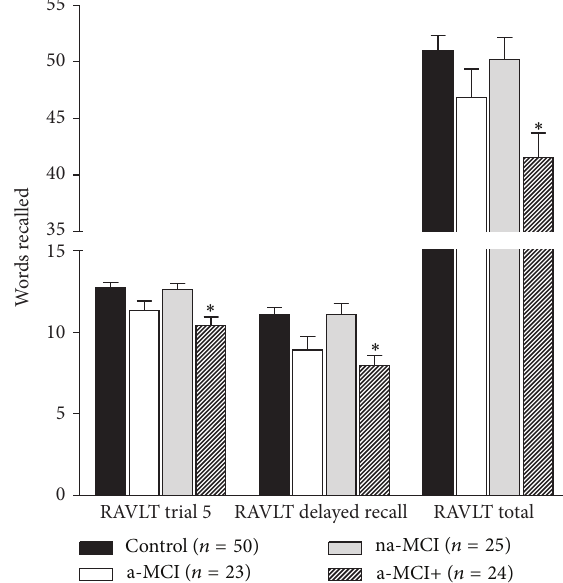
Figure 1: Group differences visual episodic memory (mean ± SEM). Figure 2: Group differences verbal episodic memory (mean ±